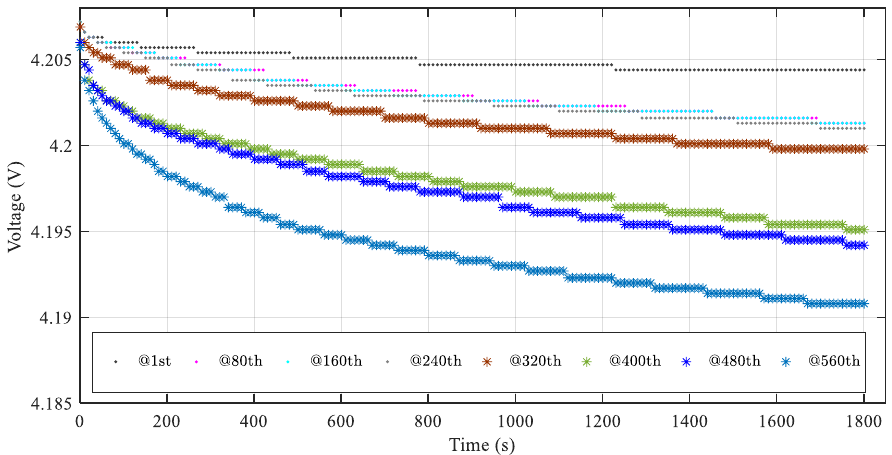
Figure 8. Changes in terminal voltage with different rest times.